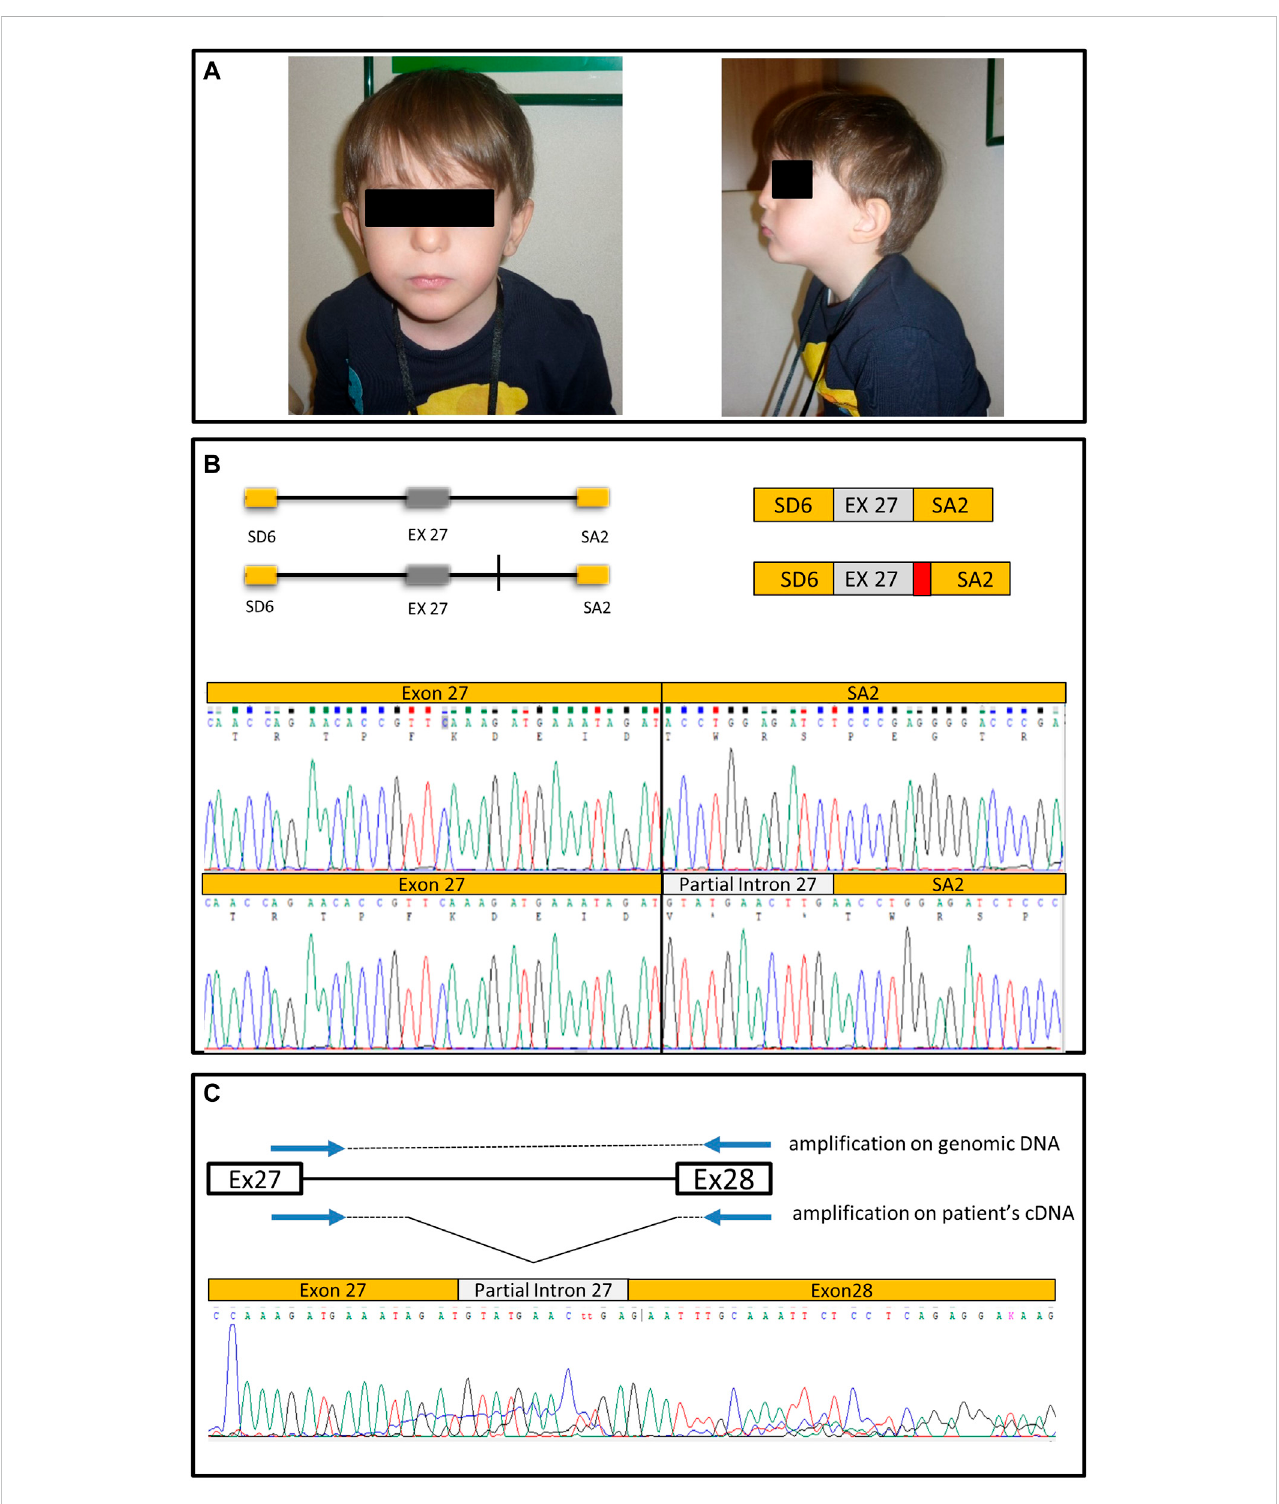
FIGURE 1 Clinical images, minigene structure and sequencing results. (A) Patient pictures. (B) Schematic representation of the wt genomic region cloned in pSPL3correspondingtotheportionofintron26,exon27andintron27clonedinpSPL3,andoftheconstructwiththeA > Gtransition(verticalline).Ontheside is represented the effect on splicing of the wt construct and of the variant construct; in the latter case resulting in partial intron retention (in red) and a premature stop codon, asshownbytherespective chromatograms. (C) Schematicofthestrategy to amplify thepathologicallyspliced alleleonpatient ’ s cDNA, and chromatogram showing the retention of a part of intron